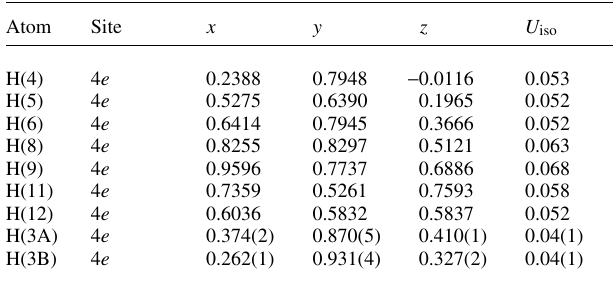
Table 2. Atomic coordinates and displacement parameters (in Å 2 ) . Table 1. Data collection and